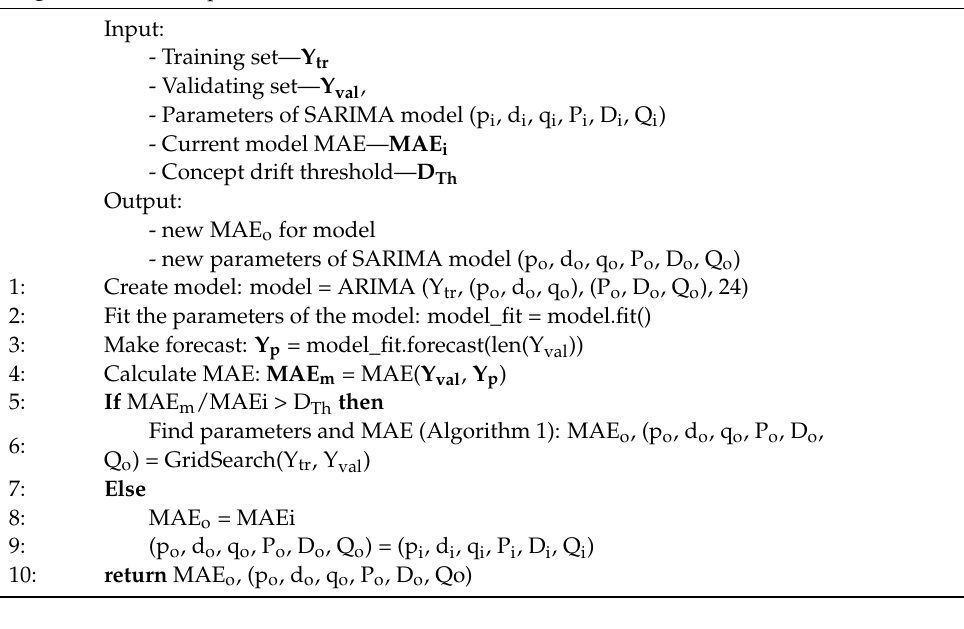
Algorithm 2: Concept drift detection.